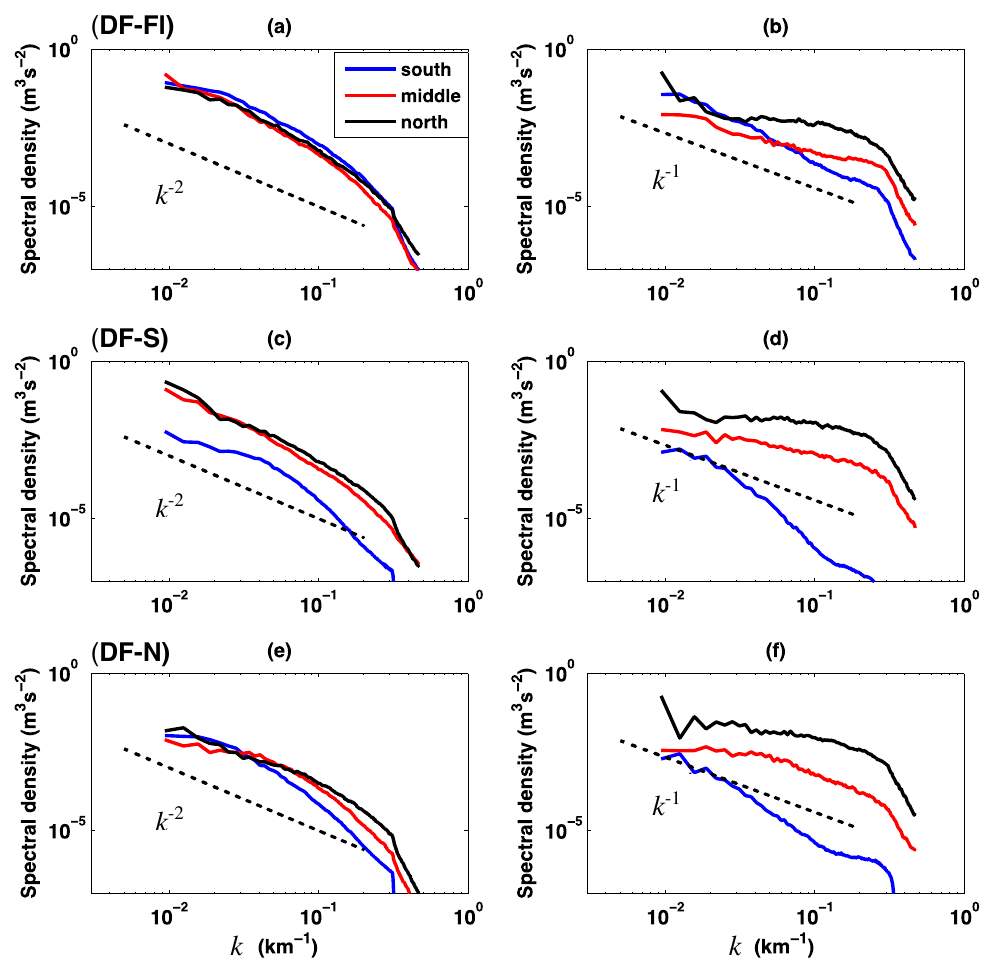
Figure 5. Spectra of surface horizontal kinetic energy (10 m depth, left panels) and vertical velocity (30 m depth, right panels) averaged from day 800 to 1000. ( a ) Kinetic energy spectra and ( b ) vertical velocity spectra in Experiment DF-Fl. ( c ) Kinetic energy spectra and ( d ) vertical velocity spectra in Experiment DF-S. ( e ) Kinetic energy spectra and ( f ) vertical velocity spectra in Experiment DF-N. Dotted lines represent k − 1 and k − 2 spectral slope, provided for reference. Blue lines represent the southern flank of the domain from − 300 km < y < − 100 km. Red lines represent the middle of the domain (frontal region) from − 100 km < y < 100 km. Black lines represent the northern flank of the domain from 100 km < y < 300 km. Spectra in Experiments UF-S and UF-N are similar to those in the control Experiment DF-Fl, and are not shown in this